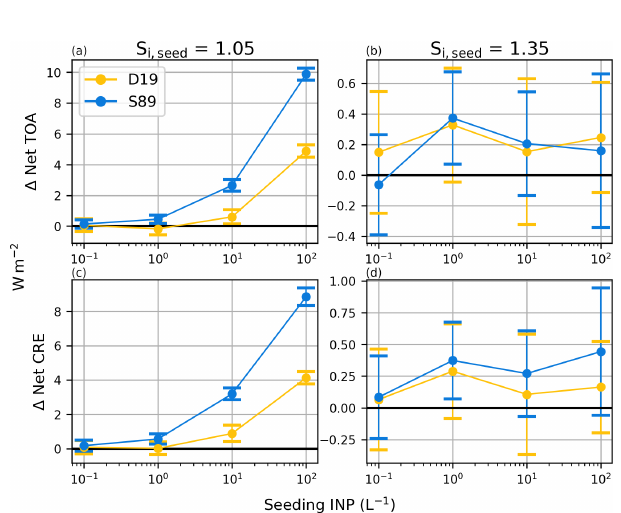
Figure 3. Five-year mean global mean net top-of-atmosphere (TOA) radiative balance anomalies in Wm − 2 between total short- wave and longwave fluxes and cloud radiative fluxes comprising the CRE. Anomalies are defined as the differences between each seeding simulation and the reference simulation without seeding. The left column (a, c) shows the radiative anomalies for simula- tions with S i,seed = 1.05, and the right column (b, d) is the same for S i,seed = 1.35. The errors bars represent the 95% confidence (2 σ ). Note the differences in scales for the S i,seed = 1.05 plots and the S i,seed = 1.35